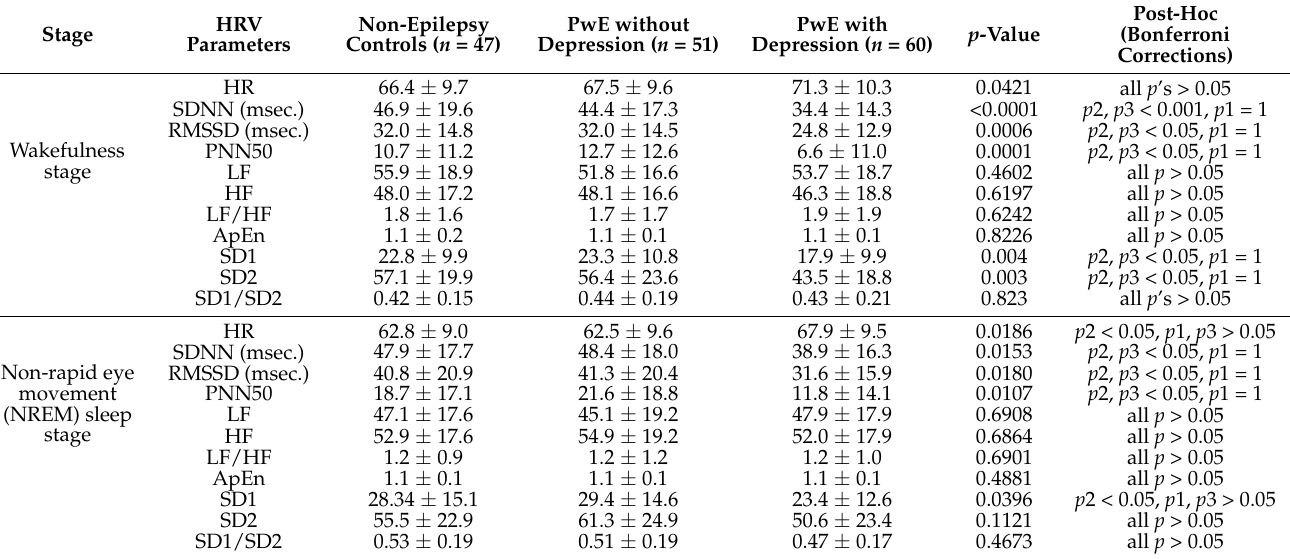
Table 3. Comparison of HRV parameters between PwE and non-epilepsy